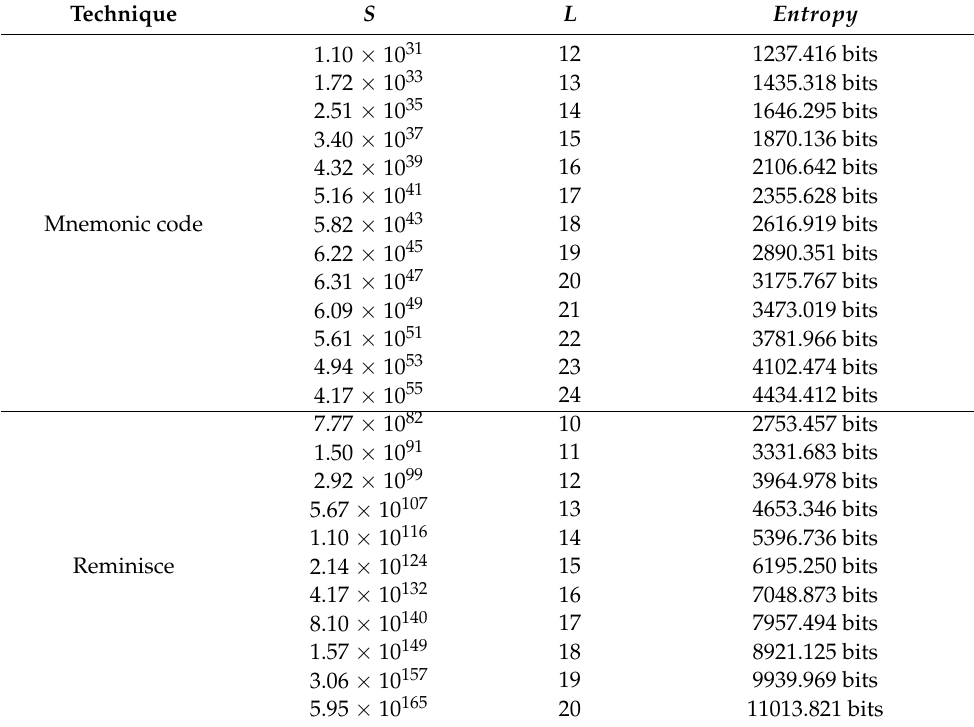
Table 4. Entropy